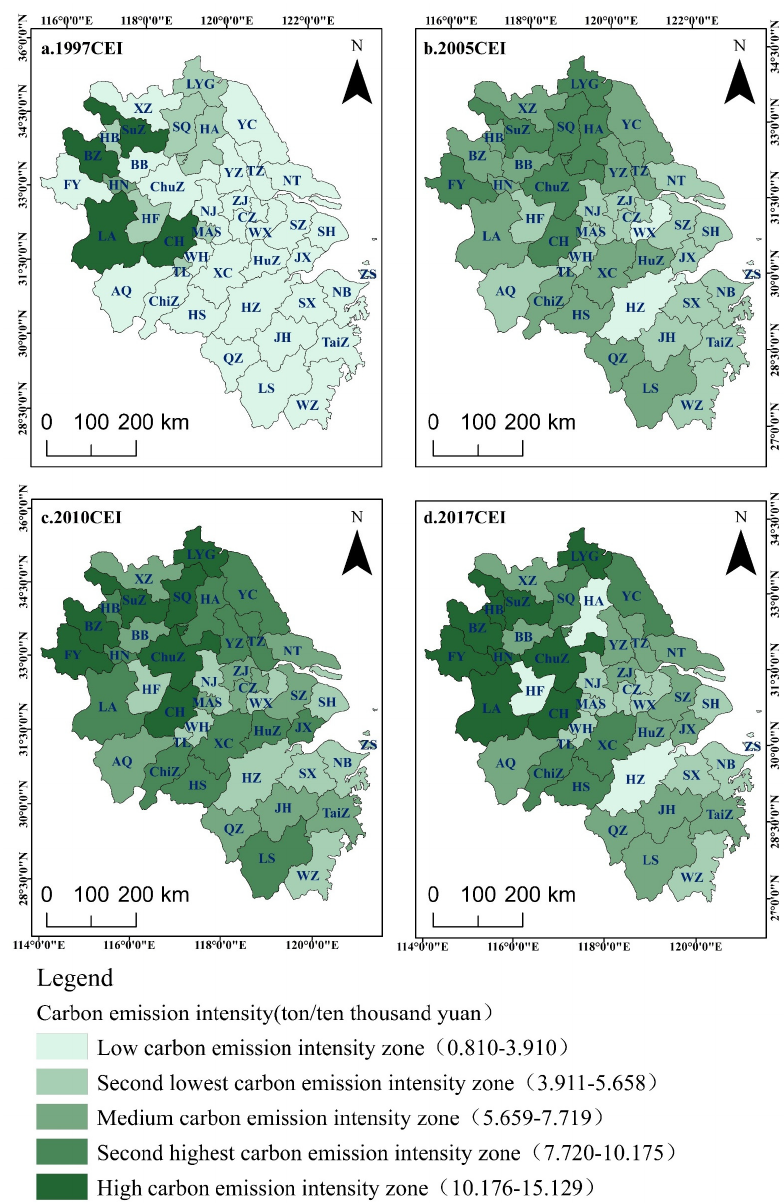
Figure 4. Spatial distribution of carbon emission intensity in the Yangtze River Delta from 1997 to 2017. (( a ). Spatial distribution of carbon emission intensity in the Yangtze River Delta in 1997; ( b ). Spatial distribution of carbon emission intensity in the Yangtze River Delta in 2005; ( c ). Spatial dis- tribution of carbon emission intensity in the Yangtze River Delta in 2010; ( d ). Spatial distribution of carbon emission intensity in the Yangtze River Delta in 2017)